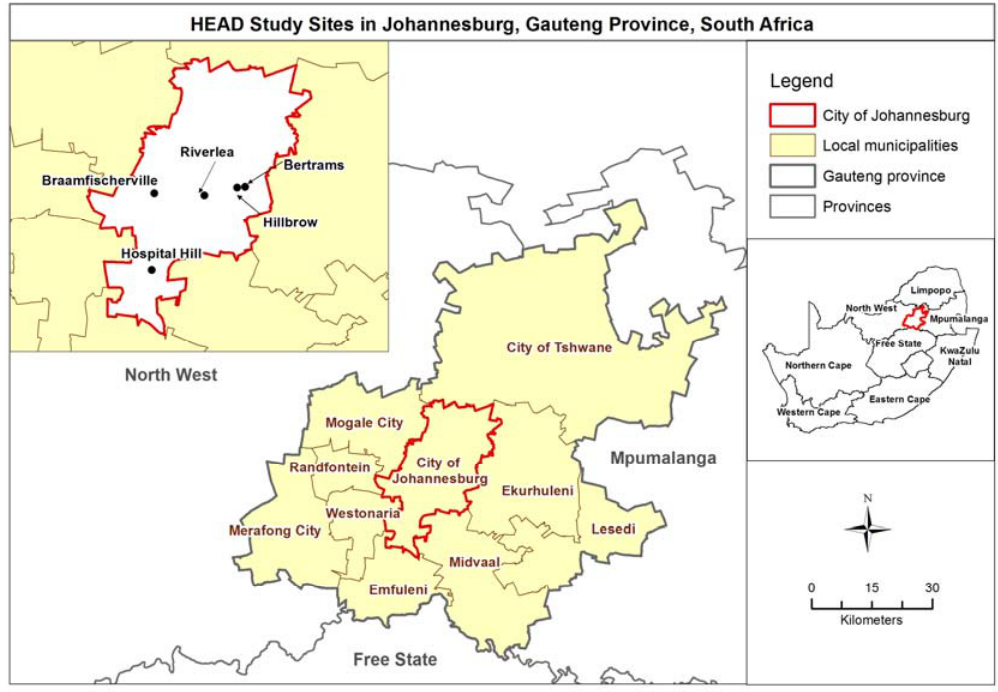
Figure 1. Location of the five study sites in the City of Johannesburg, South Africa.